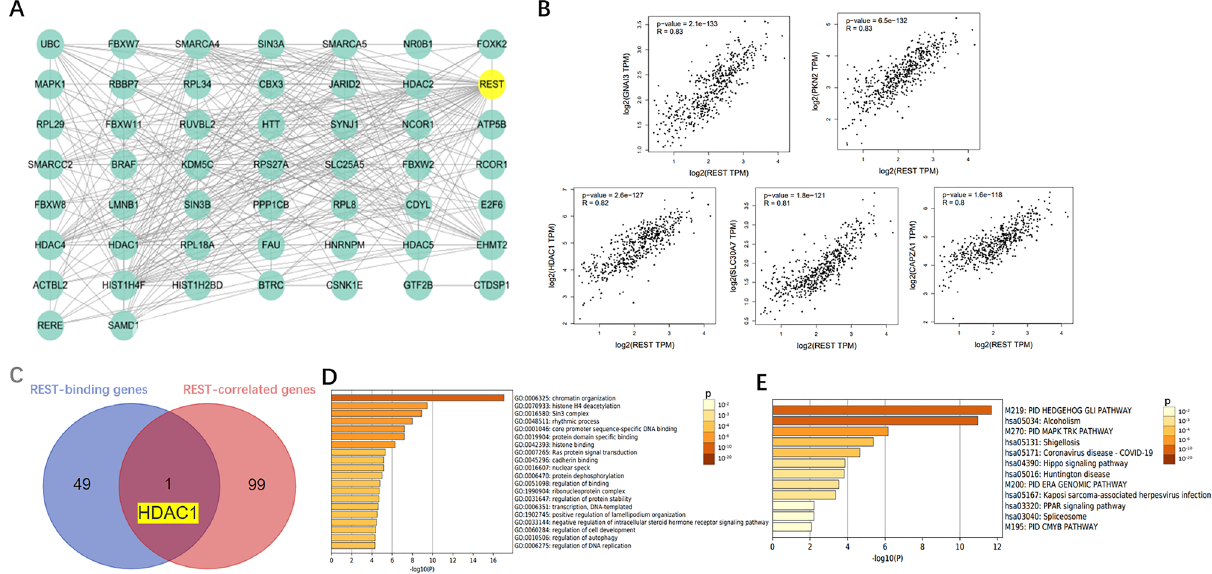
Figure 6. Enrichment analysis of REST-related partners. ( A ) The REST-binding proteins assessed by the STRING tool (https:// cn. string- db. org/). ( B ) The expression correlation between REST and top 5 REST- correlated genes in glioma by GEPIA2 (http:// gepia. cancer- pku. cn/). ( C ) An intersection analysis of the REST- binding genes and REST-correlated genes by Venn web (http:// bioin forma tics. psb. ugent. be/ webtools/Venn/). ( D , E ) GO analysis or KEGG and canonical pathways of the REST-related genes by Metascape tool (https:// metas cape. org/ gp/ index. html#/